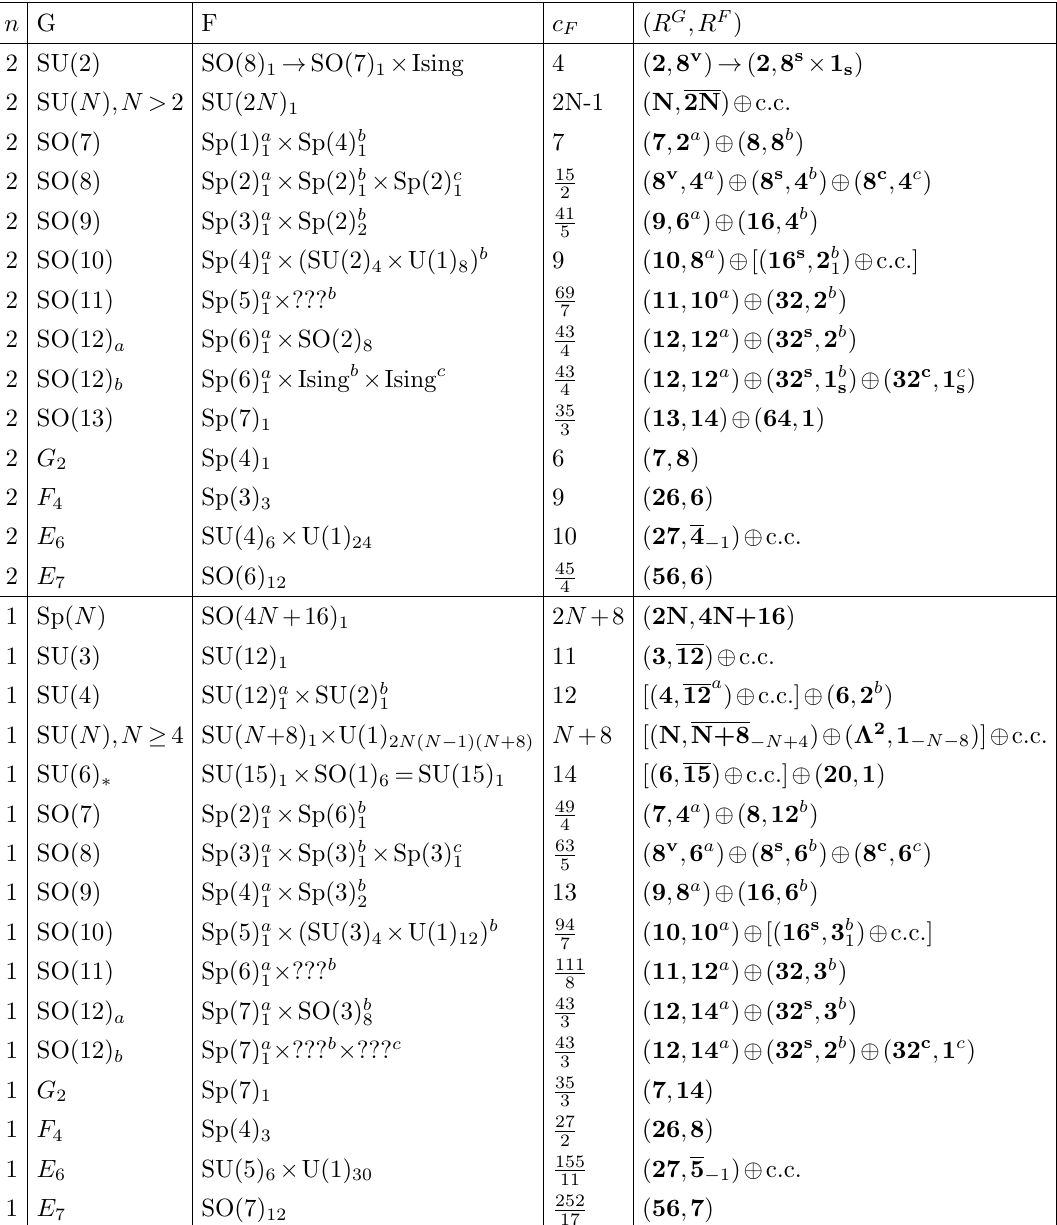
Table 21. Flavor symmetry F of the theories h G symbolizes the N ( N (cid:0) 1) -dimensional antisymmetric representation of SU( N ). We indicate by 2